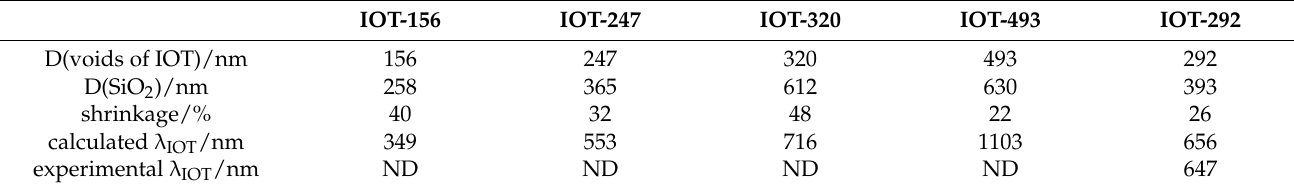
Table 2. Properties of opals and IOT samples prepared by infiltration